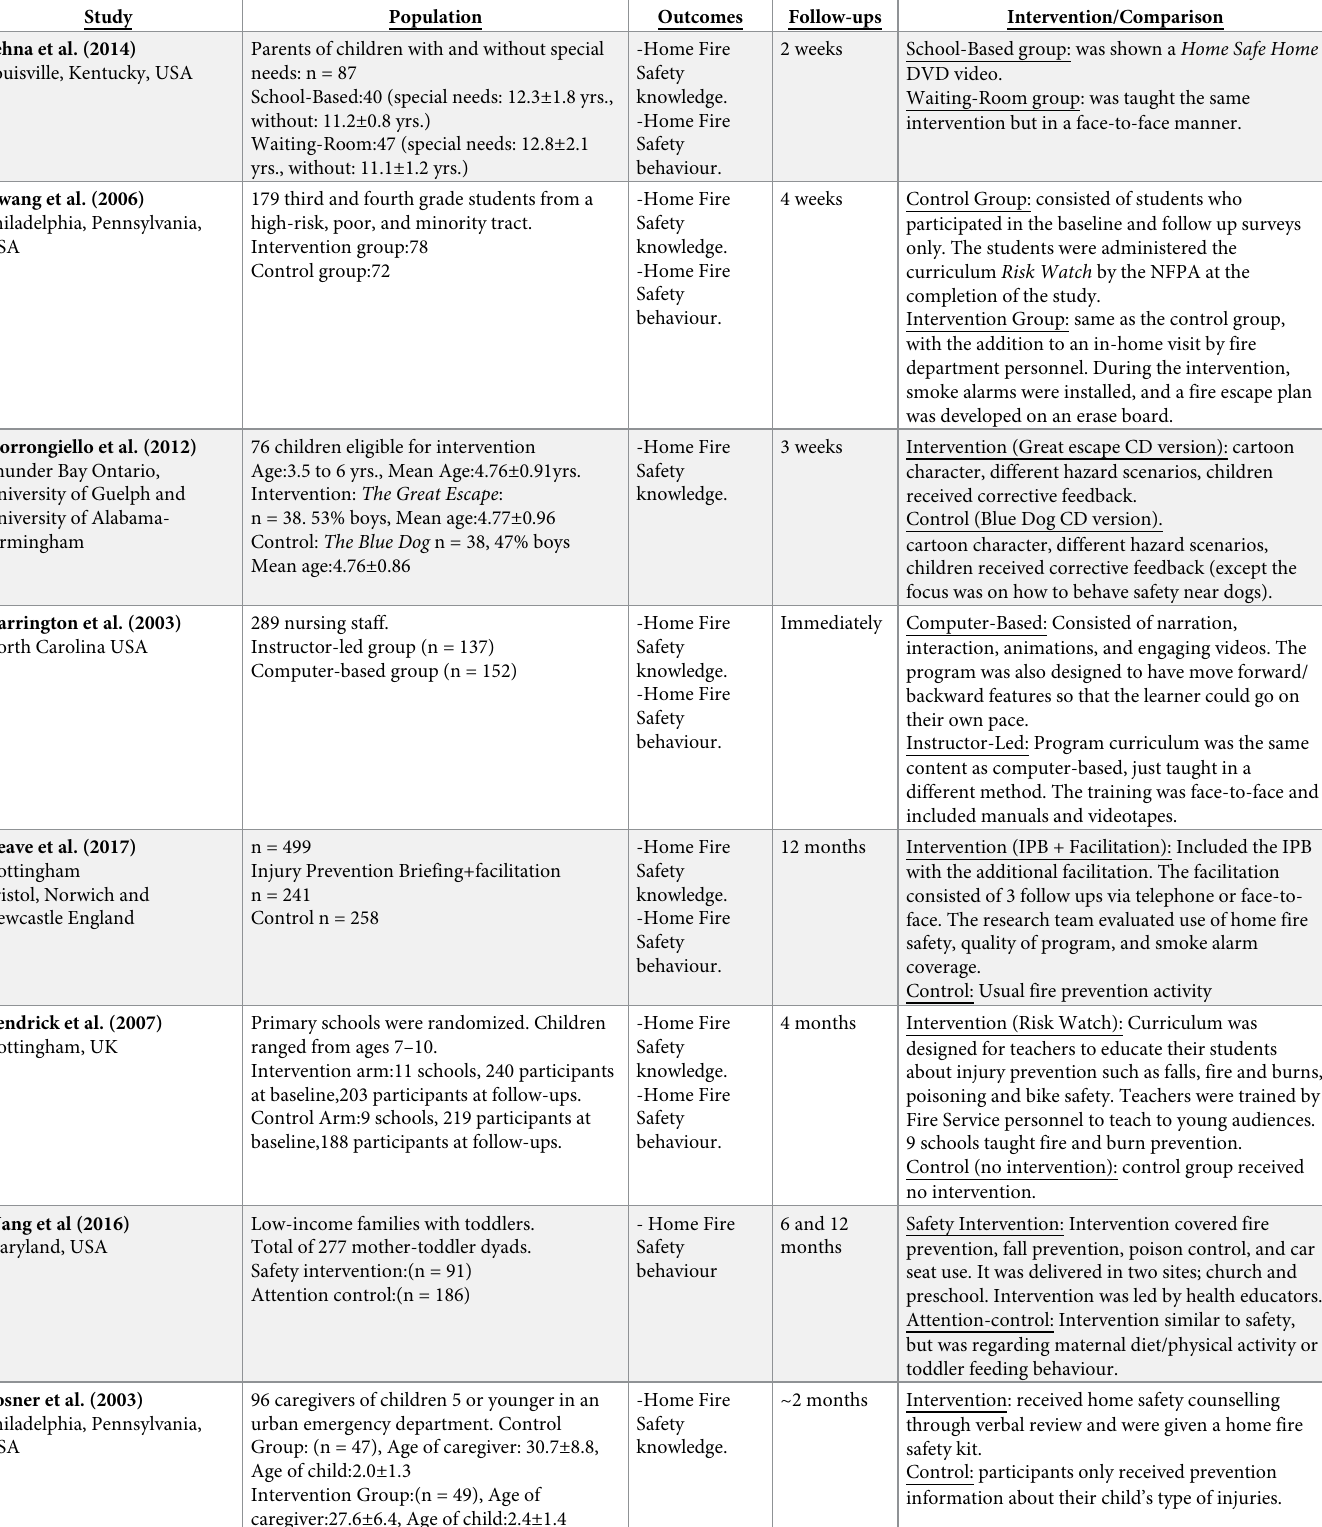
Table 1. Study characteristics of the included randomized controlled